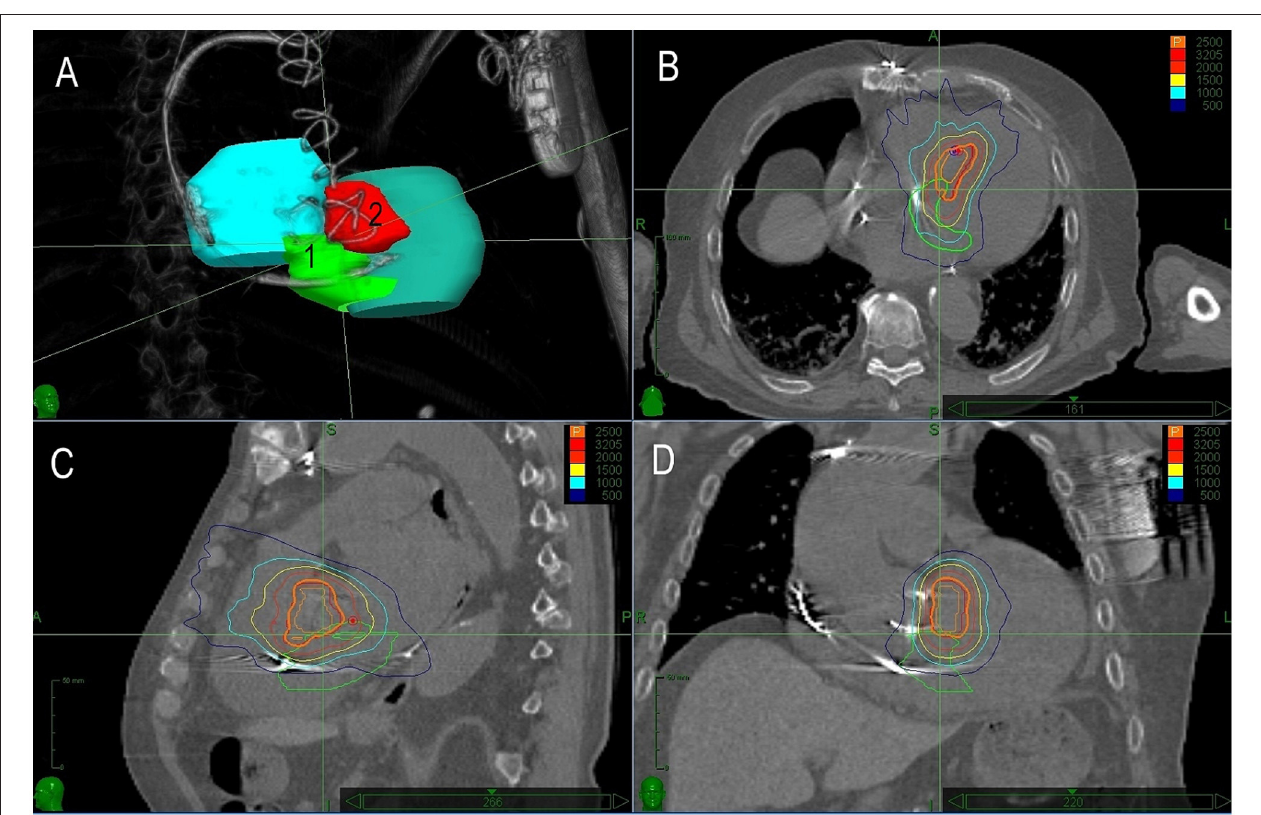
FIGURE 4 | The treatment plan for Case 3. Description of (A–D) is identical as in Figure 1 . In this case, the second planned volume covered extensive substrate within the basal septum.